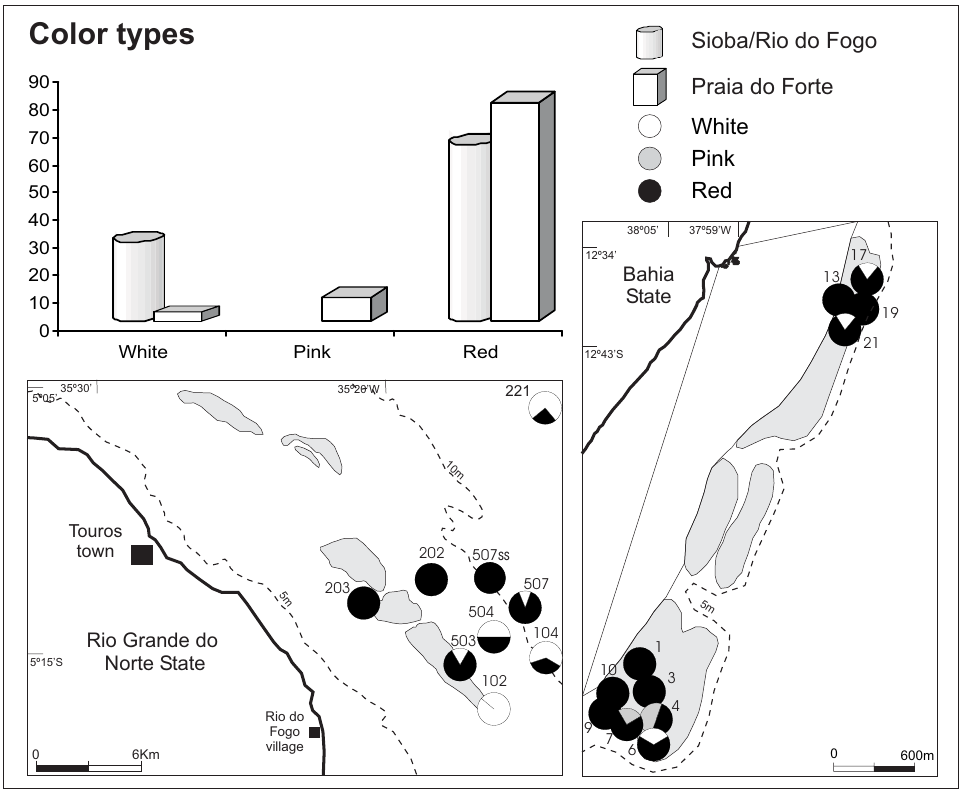
Fig. 3 – Distribution of the Homotrema colored tests found in the studied reef